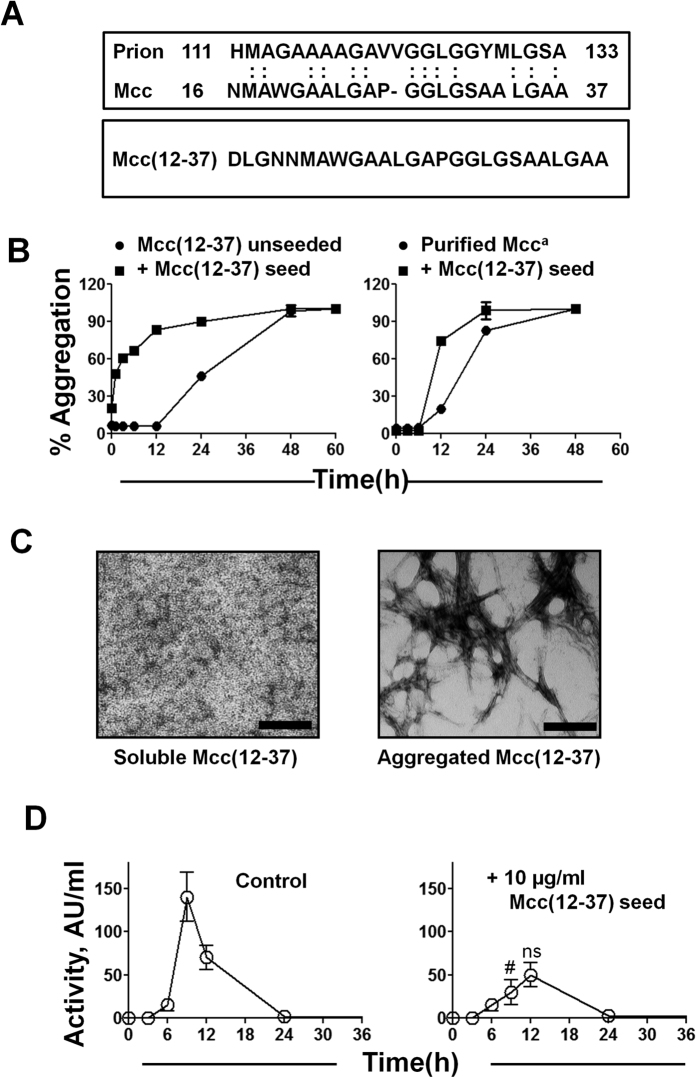
Identification of a prion domain in Mcc with sequence similarity to human PrP.(A) Sequence similarity between mature Mcc (residues 16–37) and human PrP (amino acids 111–133) (upper panel). Amino acid sequence of a synthetic peptide spanning residues 12–37 of mature Mcc used to model the PrD. (B) Synthetic Mcc(12-37) (228 μg/ml) and purified soluble Mcca (400 μg/ml) were incubated in the absence (⦁) or in the presence (▪) of preformed aggregates (seeds) of Mcc(12-37) (11 μg/ml) in aggregation buffer until 60 h at 37 °C. (C) The morphological analysis by TEM of soluble Mcc(12-37) (left panel) and aggregated Mcc(12-37) (right panel). The bars represent 100 nm. (D) Mcc producing bacteria were grown in minimal medium at 37 °C either in the absence (control) or in the presence of preformed Mcc(12-37) aggregates. Aliquots were removed at indicated times and Mcc activity was measured by CDM. Activity was measured in duplicate samples and error bars indicate S.D. The differences in Mcc activity between control and treated samples at 9 and 12 h were analyzed by two-way ANOVA with Bonferroni post-test (ns, P > 0.05; #P < 0.001).